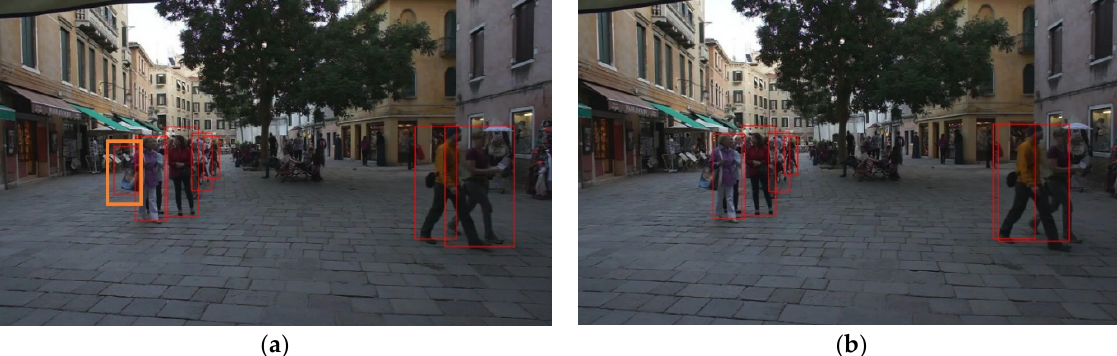
Figure 10. Tracing effect after using filter. ( a ) Before using the filter of negative sample; ( b ) after using the filter of negative sample.